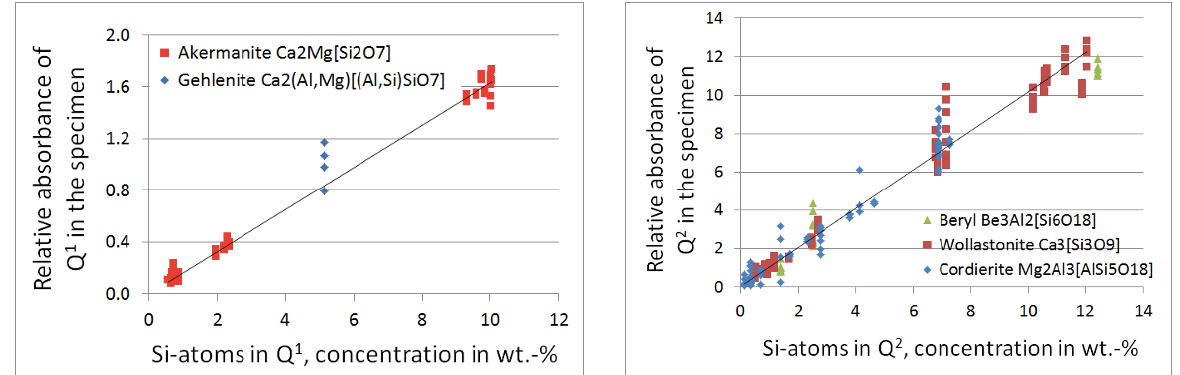
Figure 1. Calibration curves for the Q 1 (left) and Q 2 (right) structural units in